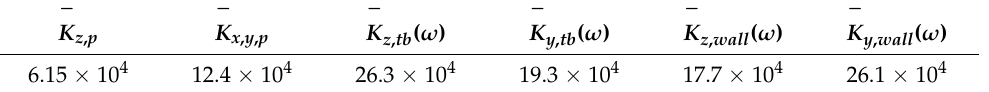
Not modelled, NP = no plaster, YP = yes plaster.